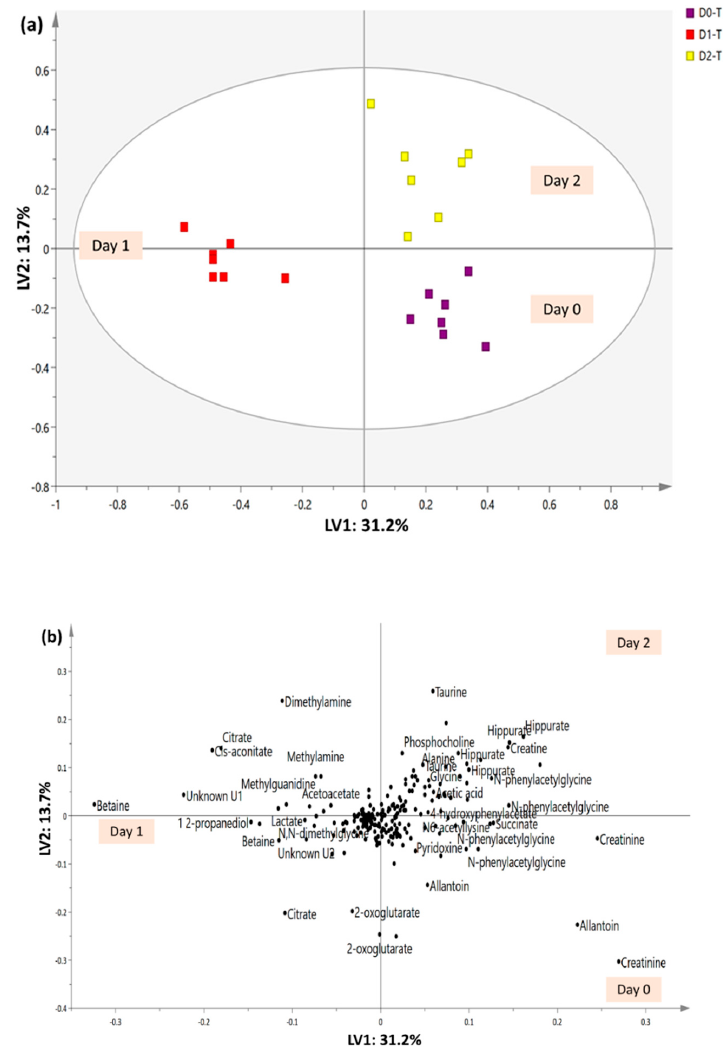
Figure 5. PLS-DA ( a ) score and ( b ) loading plots of urinary profiles trajectory trend of the treated groups collected on Day 0, 1, and 2.